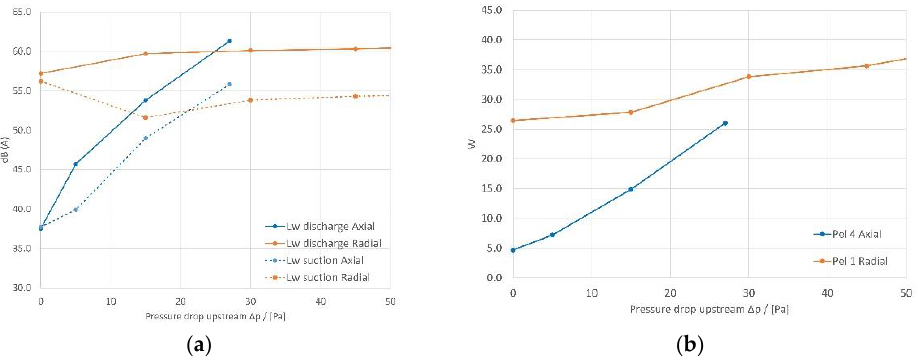
Figure 12. ( a ) Measured sound power levels (A-corrected) on discharge and suction sides and ( b ) measured electric power consumption of 4 axial fans and of a single radial fan for an air volume flow of 350 m 3 /h.